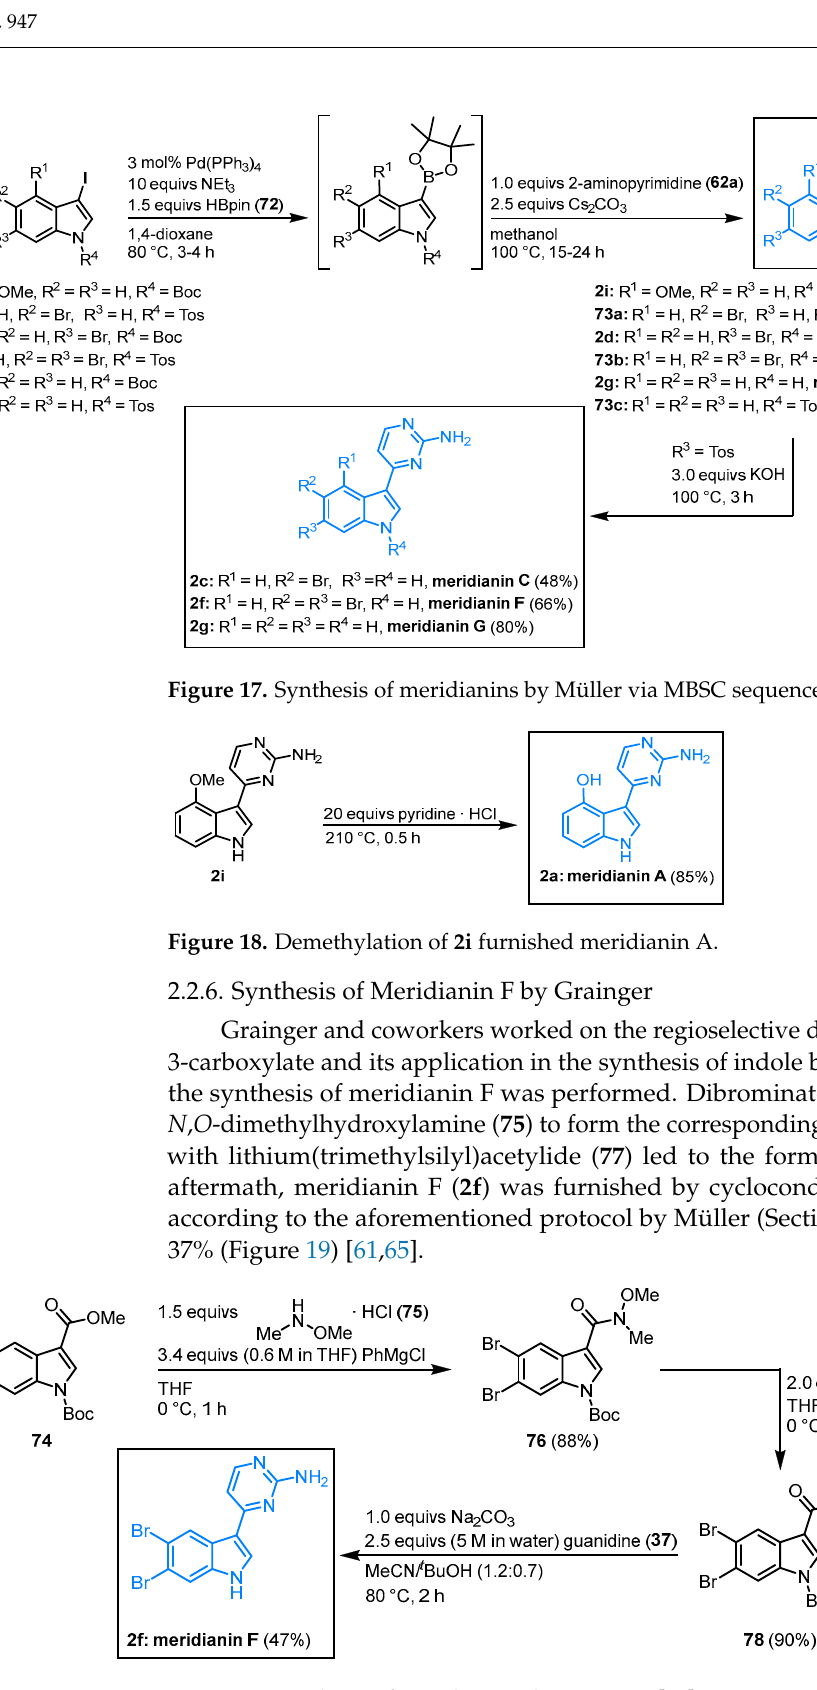
Figure 19. Synthesis of meridianin F by Grainger